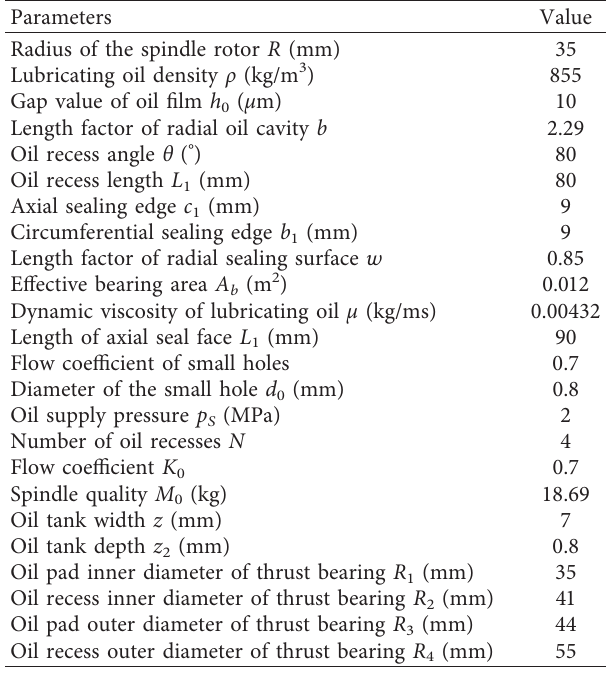
Table 1: Parameters of hydrostatic radial bearings.